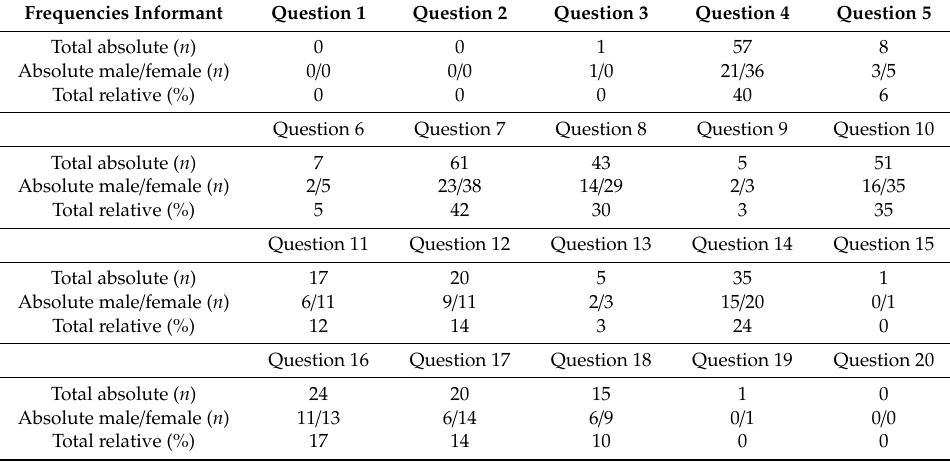
Table 1. Frequencies of response option “Not relevant” in the MedTech20 survey, presented as absolute and relative frequencies and distribution by sex per